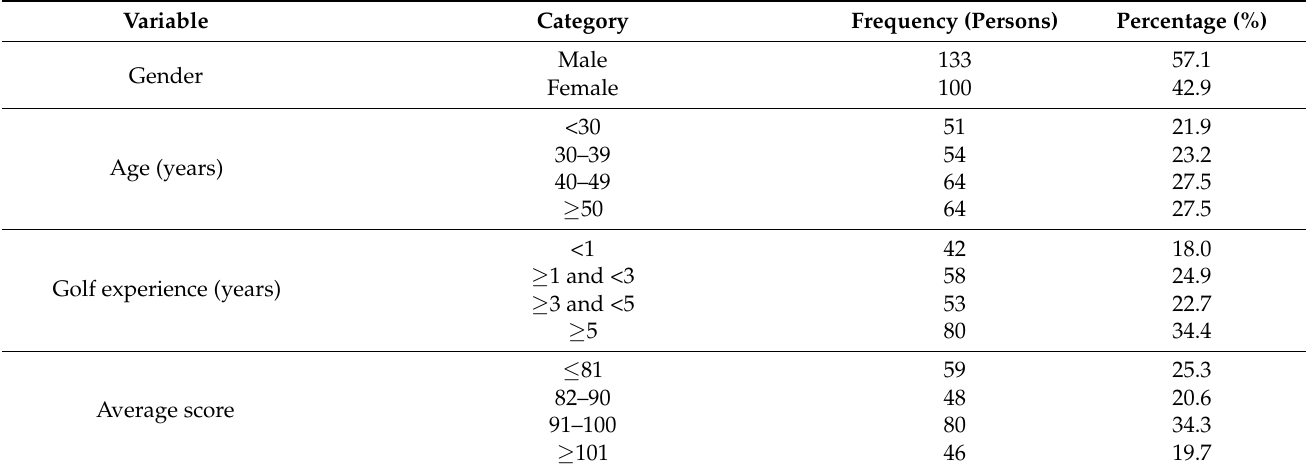
Table 3. Subjects’ general characteristics.